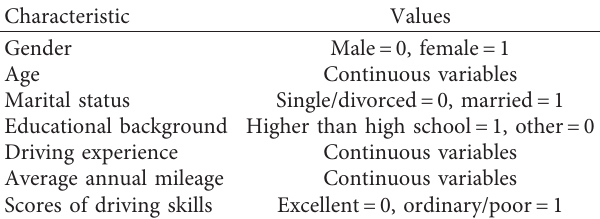
Table 4: The values of the explanatory variables. Characteristic